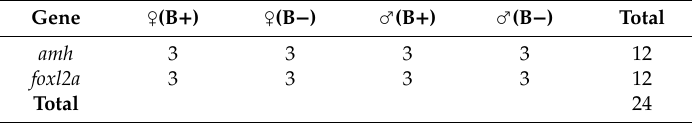
Table 2. Individual samples used in gene expression analysis.